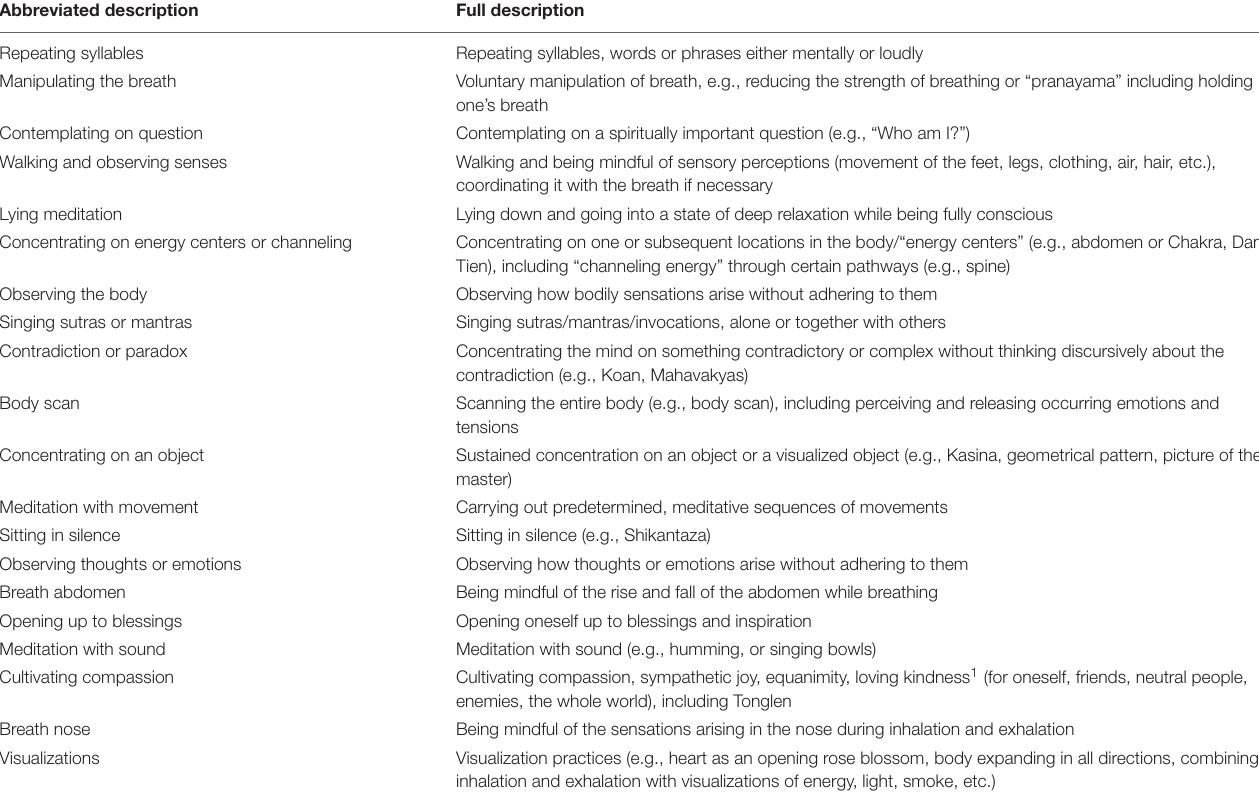
TABLE 1 | List of 20 basic meditation techniques used in the present study, in their abbreviated and full descriptions. Abbreviated description Full